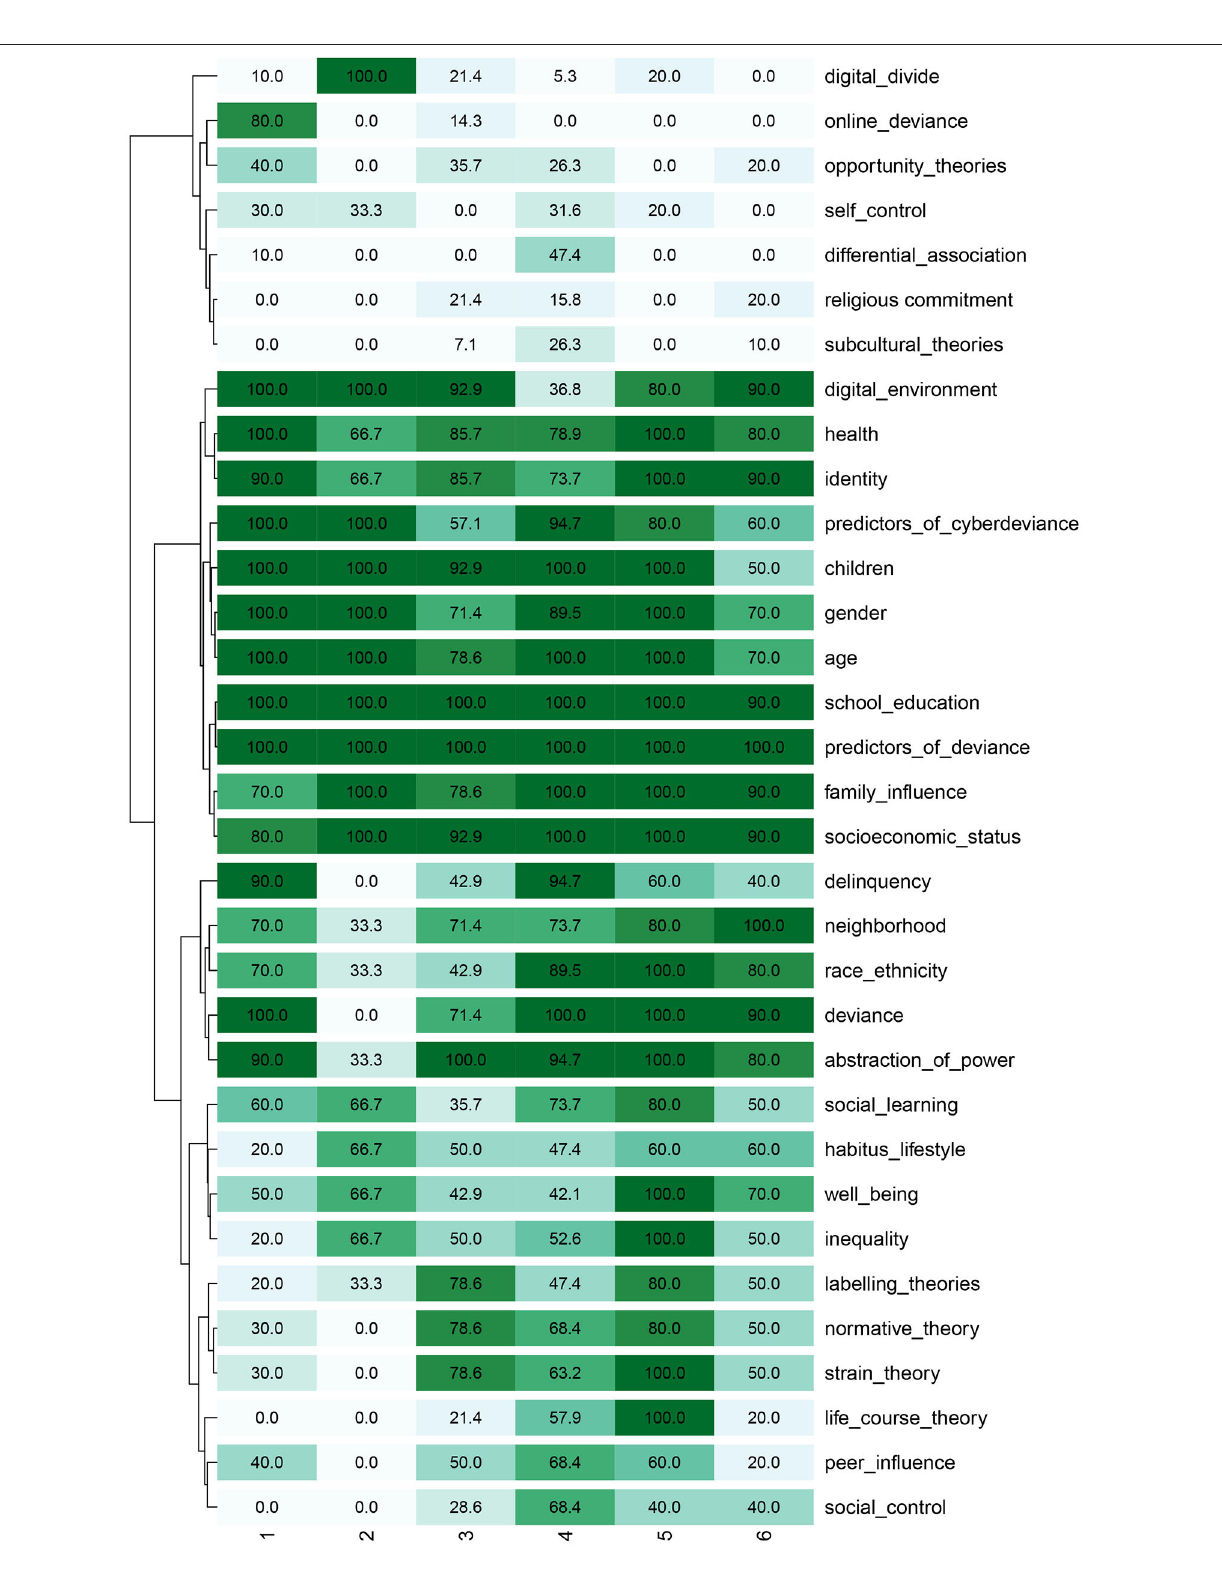
FIGURE 7 | Heat map of the in extenso